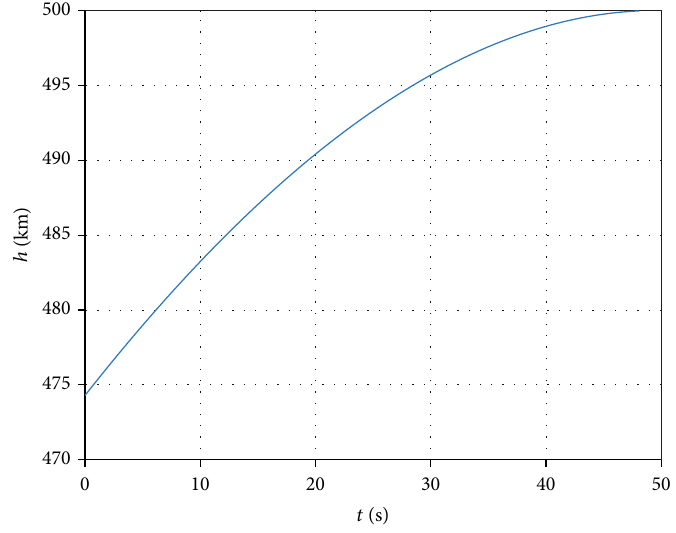
Figure 4: Time history of the